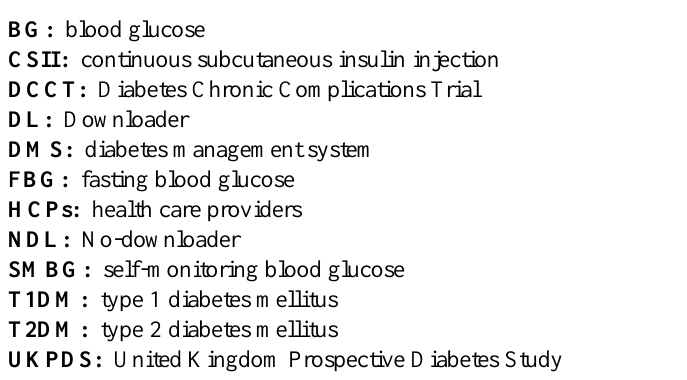
T2DM: type 2 diabetes mellitus UKPDS: United Kingdom Prospective Diabetes